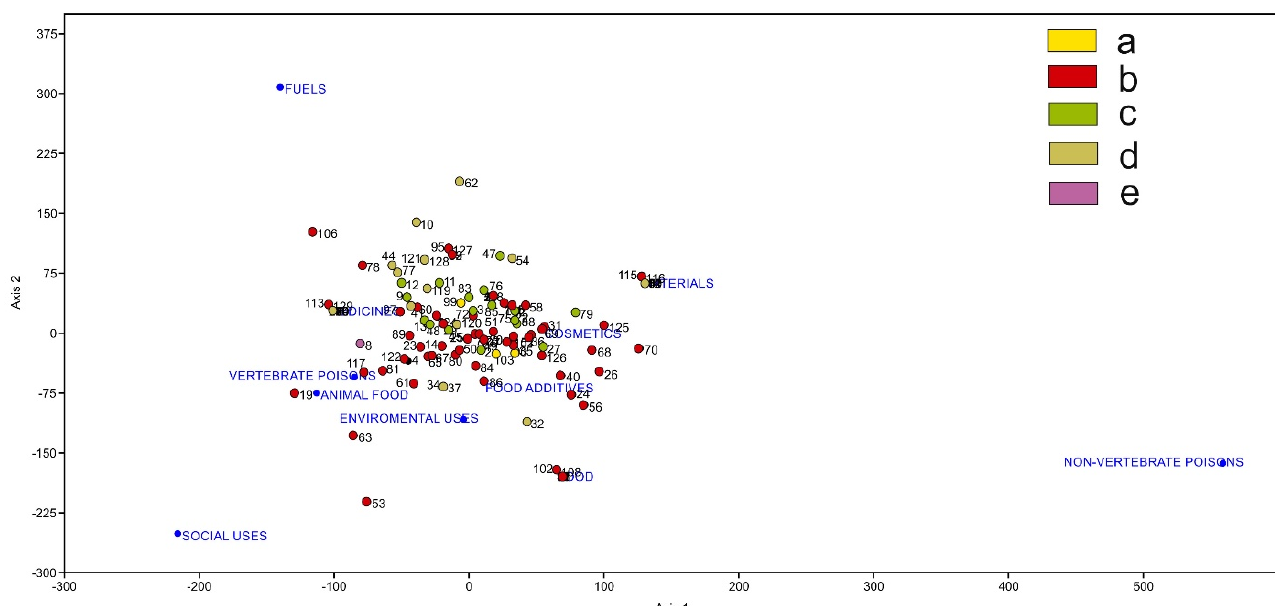
Figure 6. DCA showing the distribution of localities with different frequencies of useful plants with respect to their uses. Bioclimatic belts: a. infratropical; b. thermotropical; c. mesotropical; d. supratropical; e. orotropical.